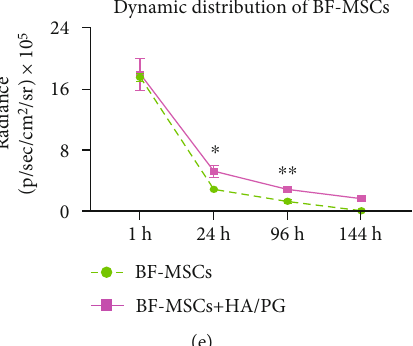
Figure 6: The dynamic metabolokinetics of BF-MSC or BF-MSC/HA/PG composite in vivo. (a, b) Representative fl uorescent images of seeded BF-MSCs with GFP (a) and luci (b) expression at a series of cell density gradients in vitro. (c) The correlation curve based on the BLI signal intensity of Fluc (radiance) and seeded cell counts. (d) Living images of BF-MSCs with or without HA/PG hydrogel composites based on the BLI signal intensity of Fluc in living imager (IVIS system) at the indicated time points. (e) The dynamic distribution curve of BF-MSCs based on cell density gradients and the BLI signal intensity of Fluc in the articular cartilage of OA rats ( mean ± SD , n = 3 ). ∗ P < 0 : 05 ; ∗∗ P < 0 : 01